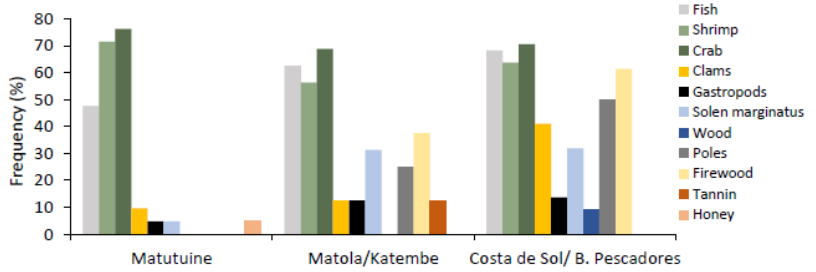
Figure 9. Exploited resources in mangrove forests of Maputo Bay according to the interviews.